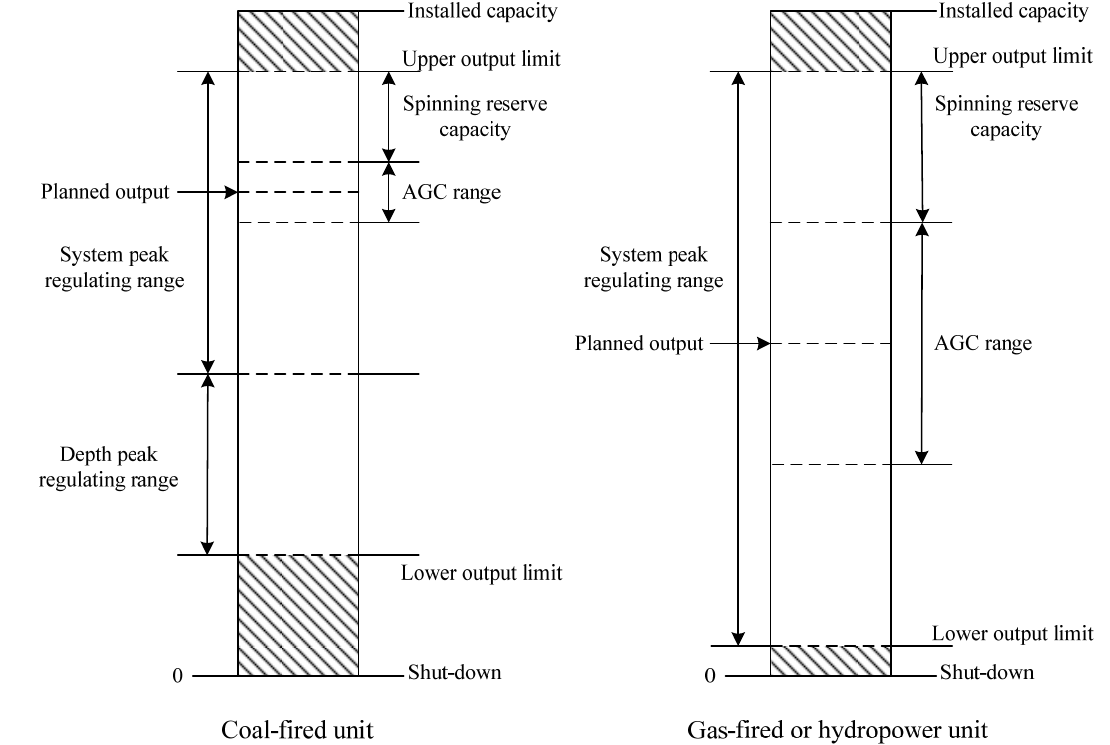
Figure 2. The capacity allocation of different types of